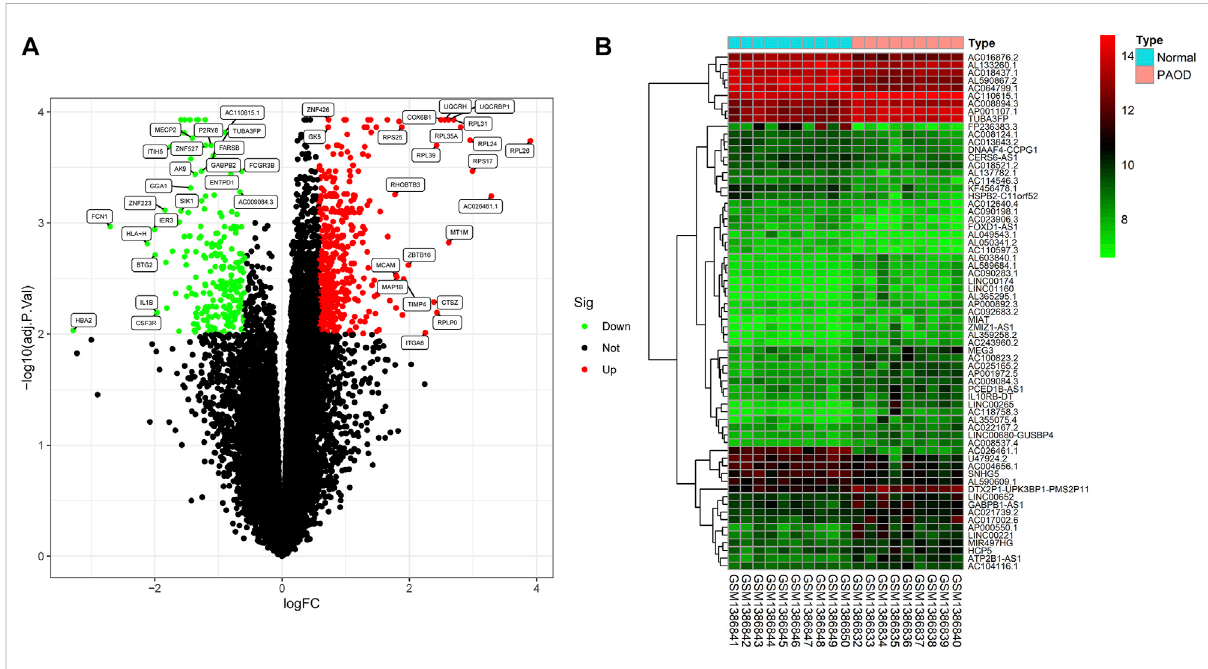
FIGURE 2 Differentially expressed (DE) mRNAs and lncRNAs in tissues between PAOD patients and normal controls. (A) Volcano plot of DE_mRNAs. (B) Heatmap of